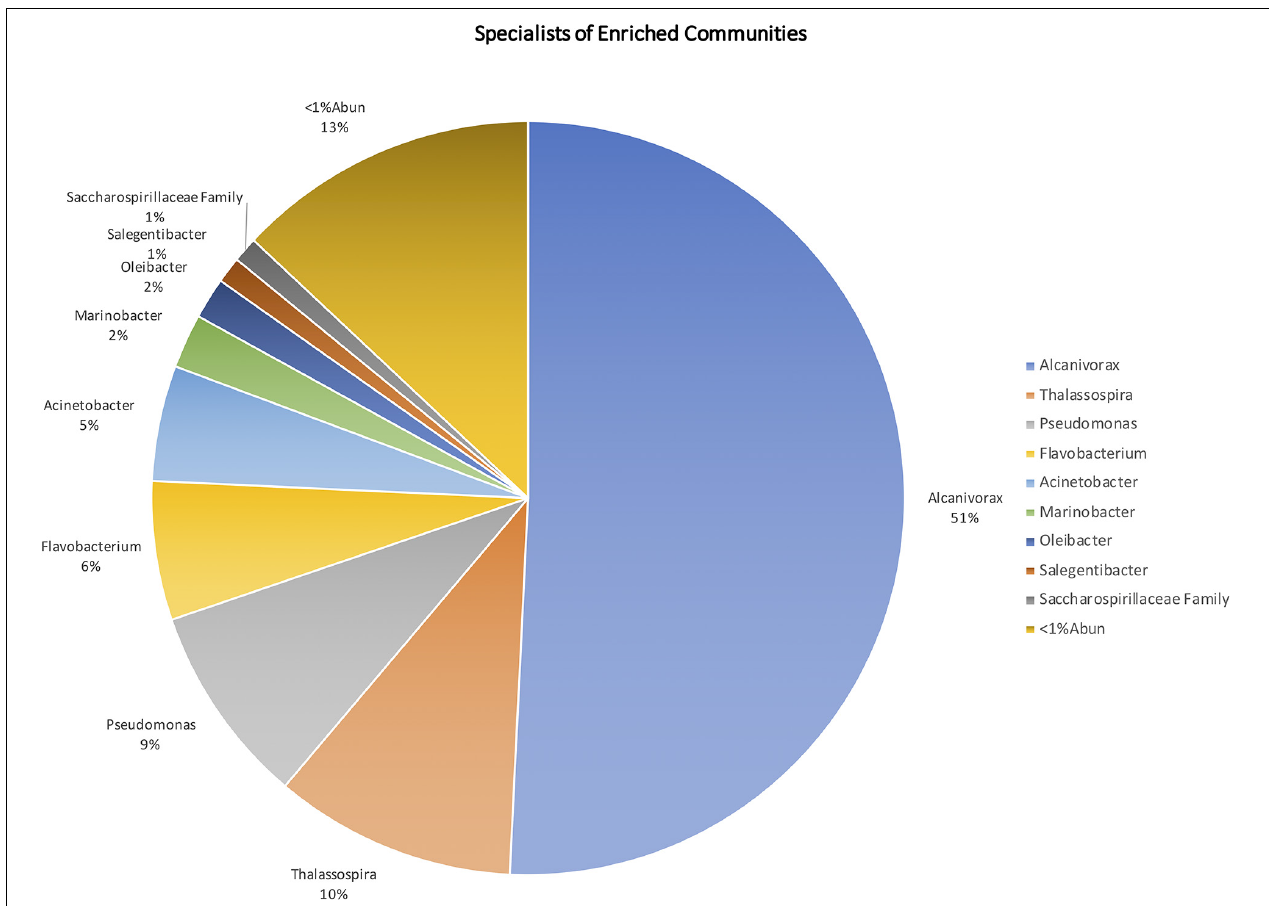
FIGURE 6 | Microorganisms present in the enriched microbial communities, at genus level, with relative abundance > 1% in relation to the total enriched